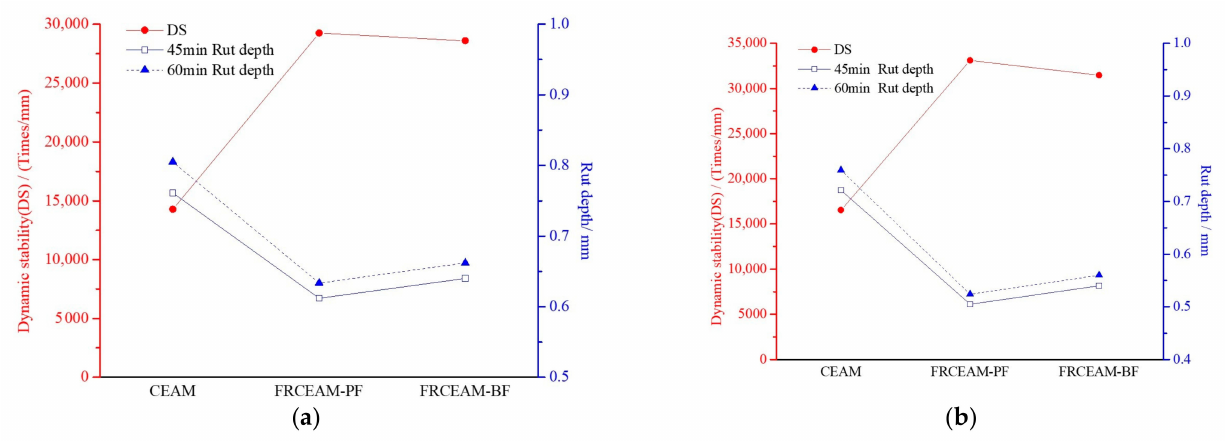
Figure 8. Dynamic stabilities of FRCEAM. ( a ) 7 d; ( b ) 28